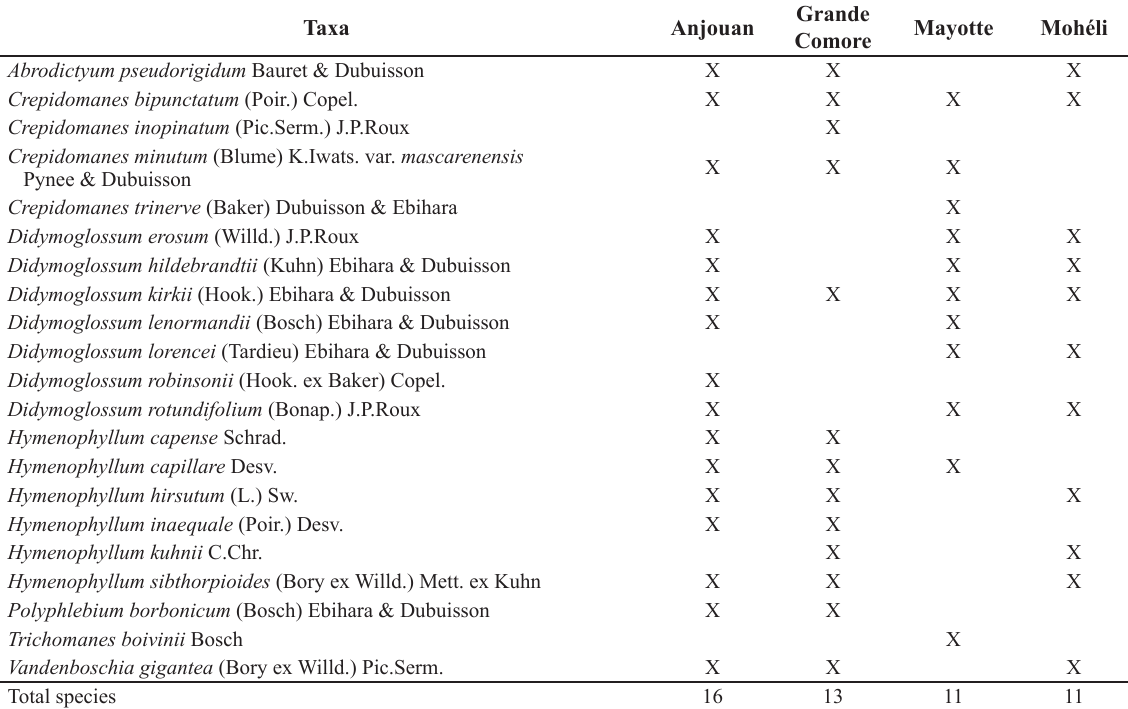
Table 2. Distribution of Hymenophyllaceae species in the Comoros islands, according to collects from the 19 th century to 2015. X = present or reported